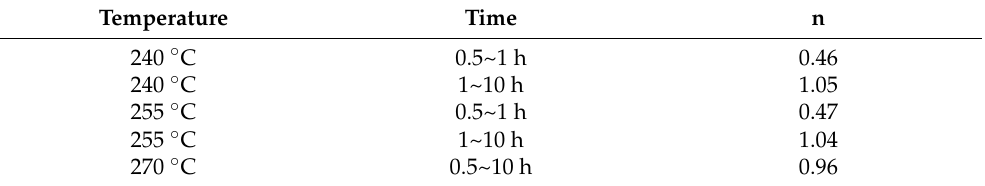
Table 3. The n values of the Cu 6 Sn 5 phase at different reaction temperatures in the SC/C194 reaction